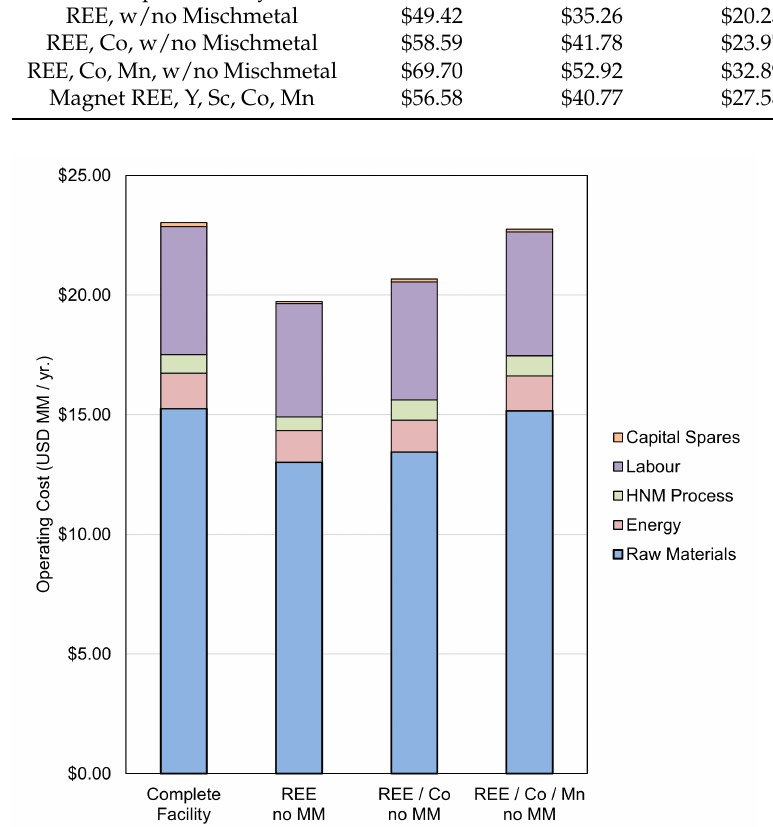
Figure 3. Operating cost breakdown for various operational